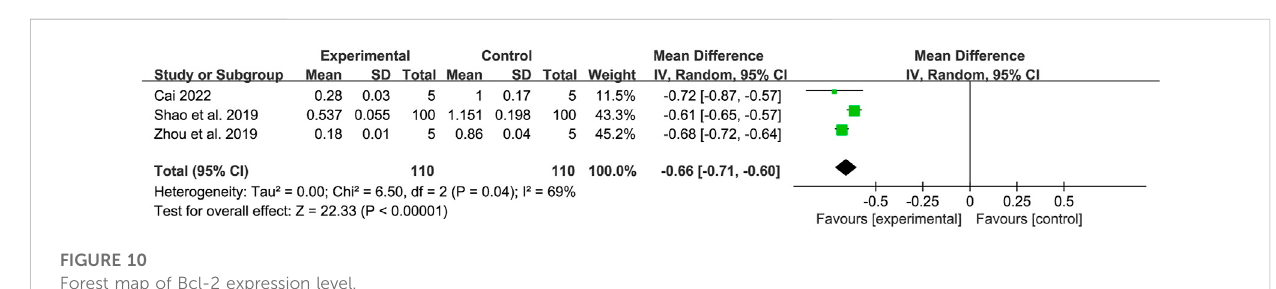
FIGURE 10 Forest map of Bcl-2 expression